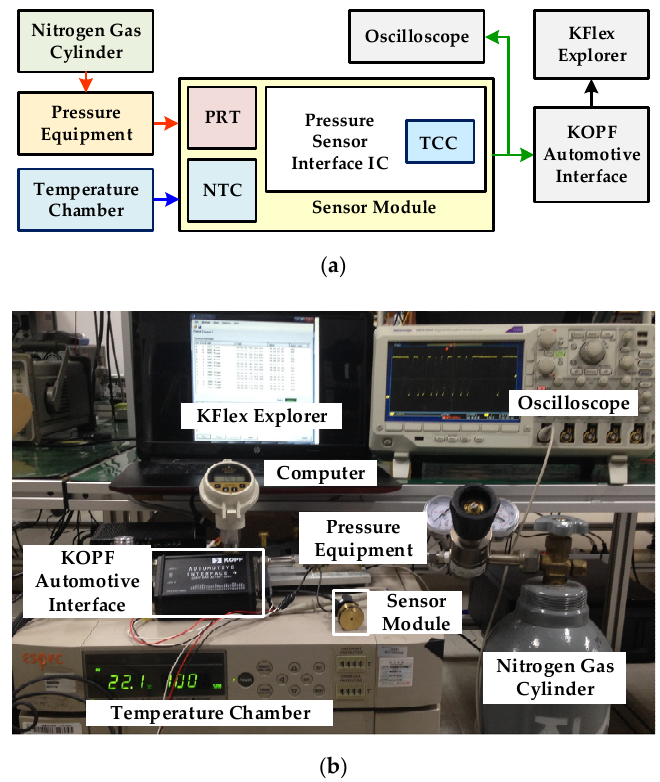
Figure 11. Experiment environment: ( a ) measurement block diagram; ( b ) experimental lab setup.